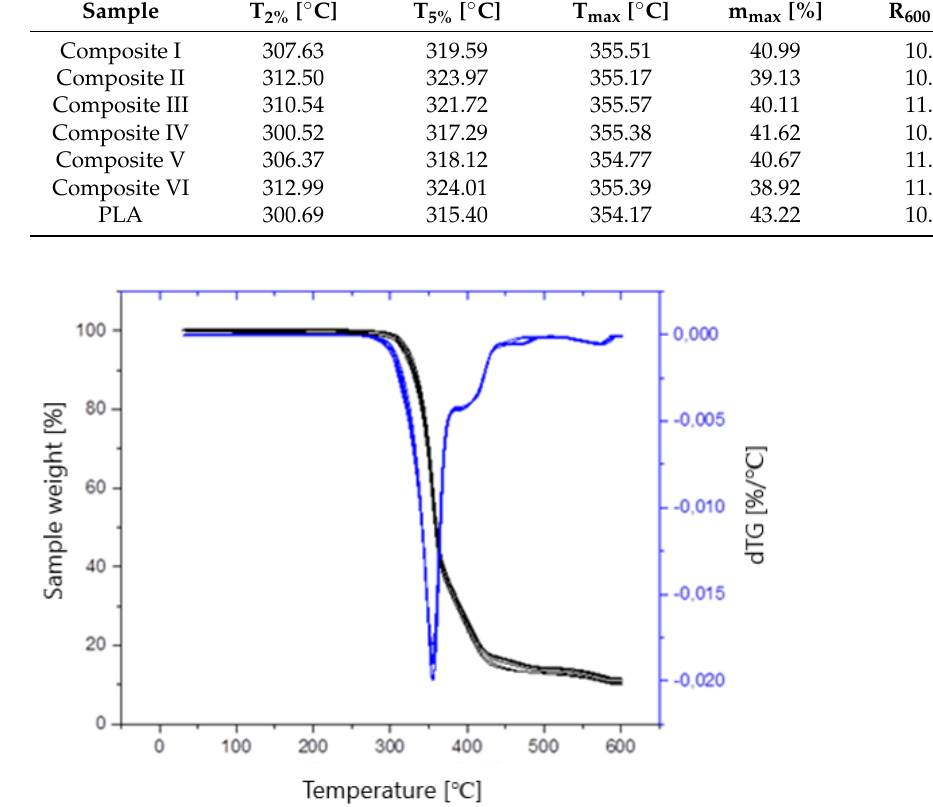
Figure 17. Thermogravimetric curve.